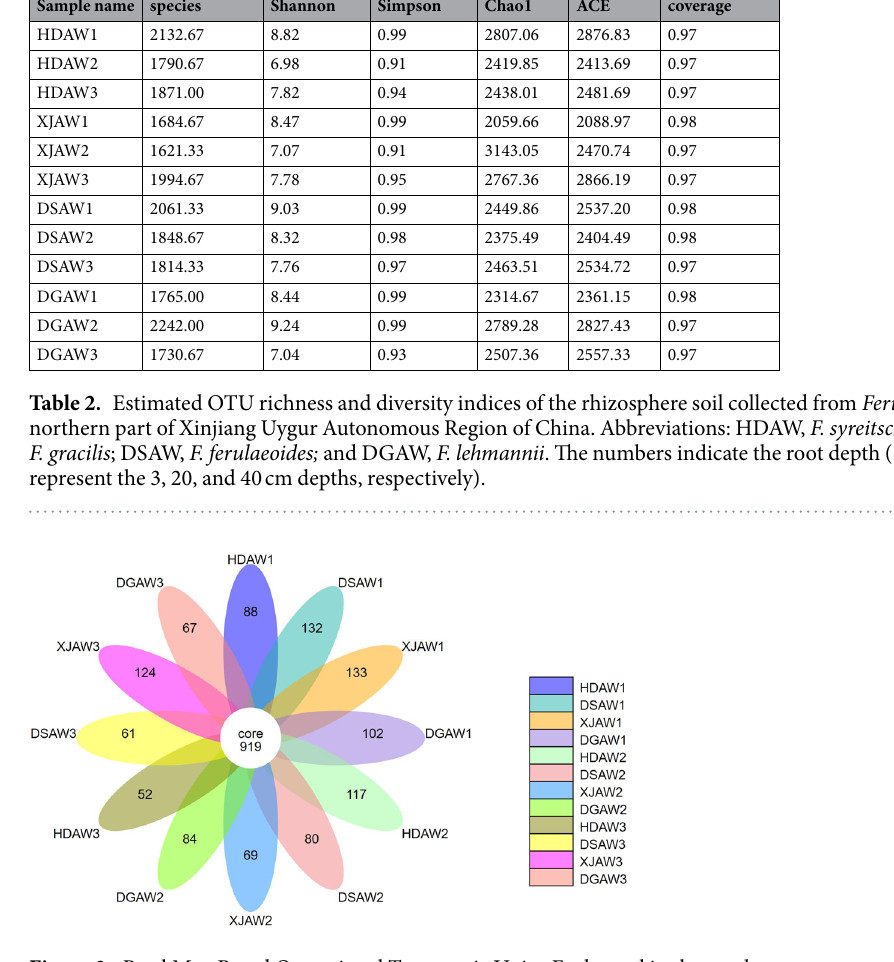
Figure 3. Petal Map Based Operational Taxonomic Units. Each petal in the petal map represents one sample, with different colors representing different samples. The middle core number represents the common OTUs of all samples, and the number on the petals represents the Unique OTU number of each sample. Abbreviations: HDAW, F. syreitschikowii ; XJAW, F. gracilis ; DSAW, F. ferulaeoides; and DGAW, F. lehmannii . The numbers indicate the root depth (1, 2, and 3 represent the 3, 20, and 40 cm depths,